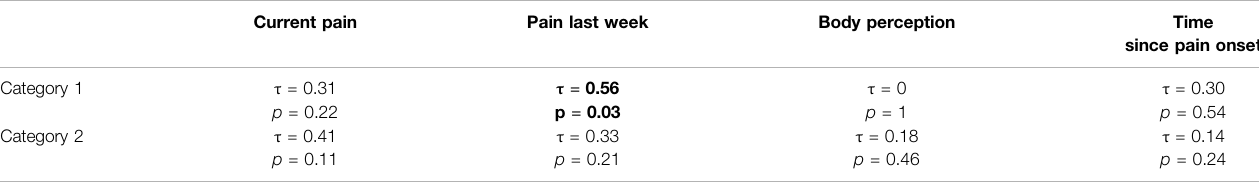
TABLE 4 | Correlation analyses. Bold indicates signi fi cant correlation. Current pain Pain last week Body perception Time